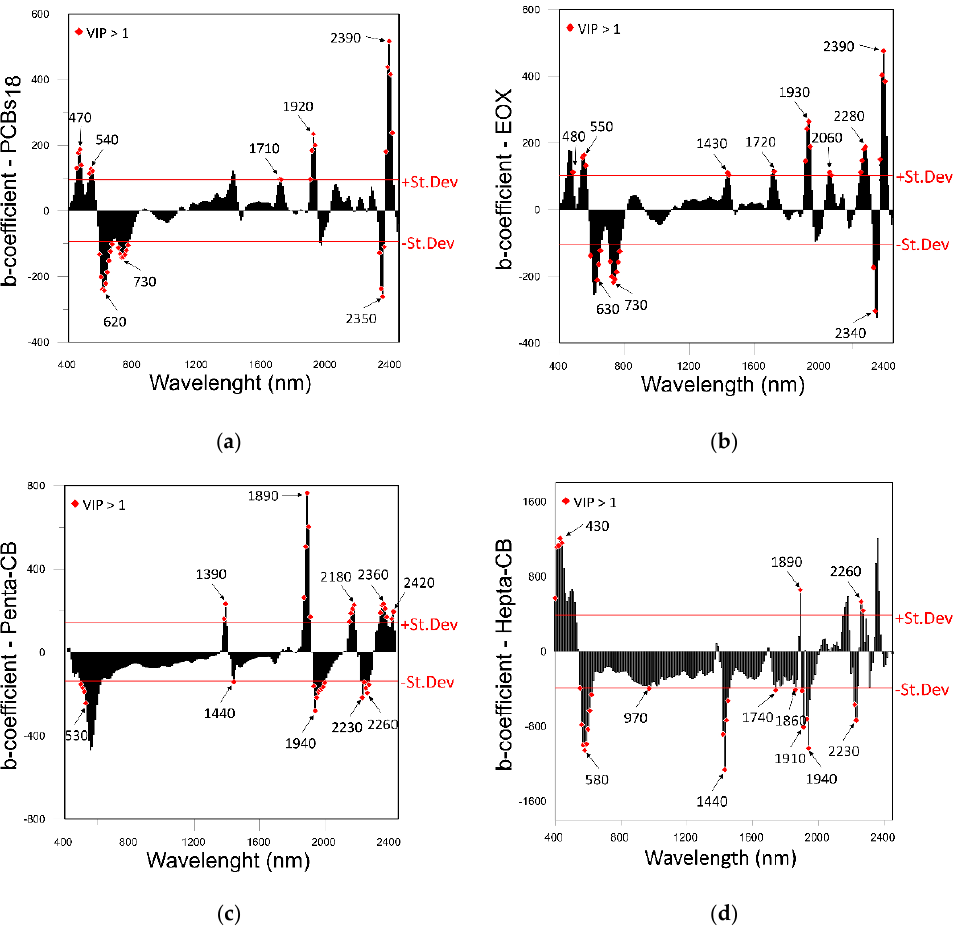
Figure 7. PLSR coefficient, b, spectra over the vis-NIR wavelength range associated with the PLSR cross-validation models for PCBs 18 ( a ), EOX ( b ), Penta-CB ( c ), and Hepta-CB ( d ). Red diamonds indicate the important wavelengths resulting from the combined use of b and the variable importance for projection (VIP). The wavelengths corresponding to the highest absolute values of b for important group wavelengths are indicated. The thresholds used for the PLSR coefficient, b (i.e., b ± st.dev.), are also shown.